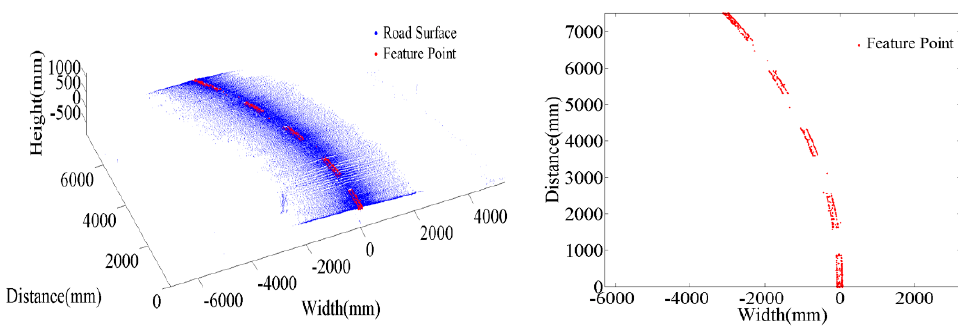
Figure 16. Feature points of a discontinuous lane.